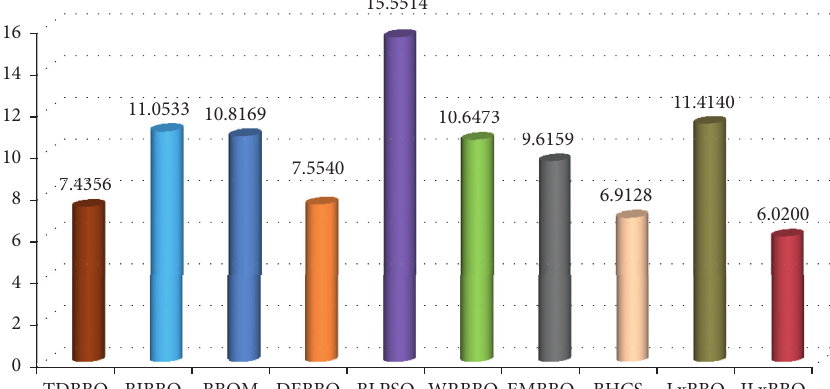
Figure 5: Average runtime comparisons of 10 algorithms on the 30-dimensional